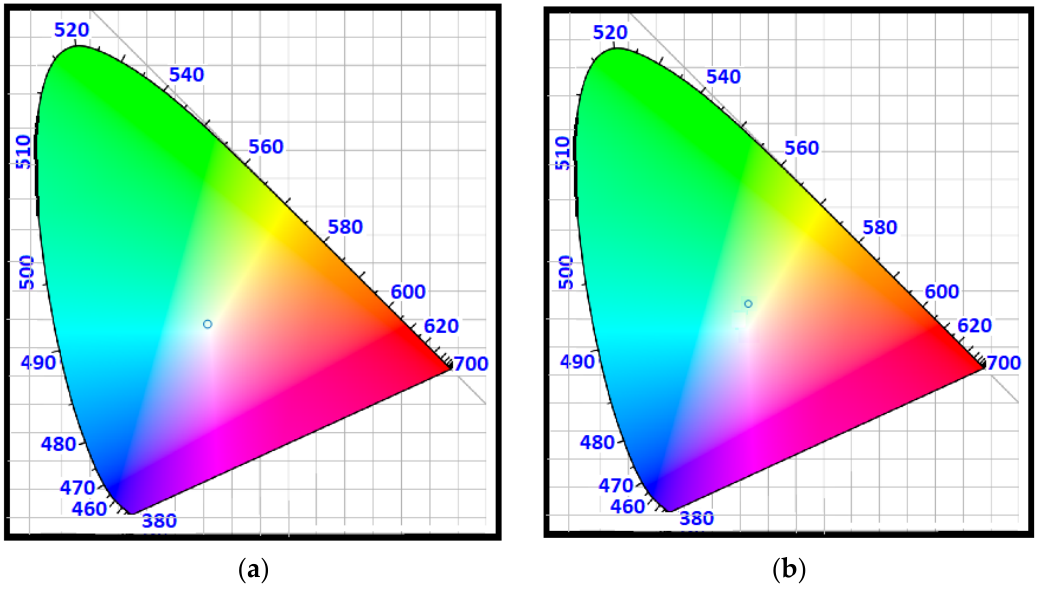
Figure 8. ( a ) White LED’s spectrum and ( b ) collected photons’ spectrum in the CIE 1931 standard observer chromaticity diagram.